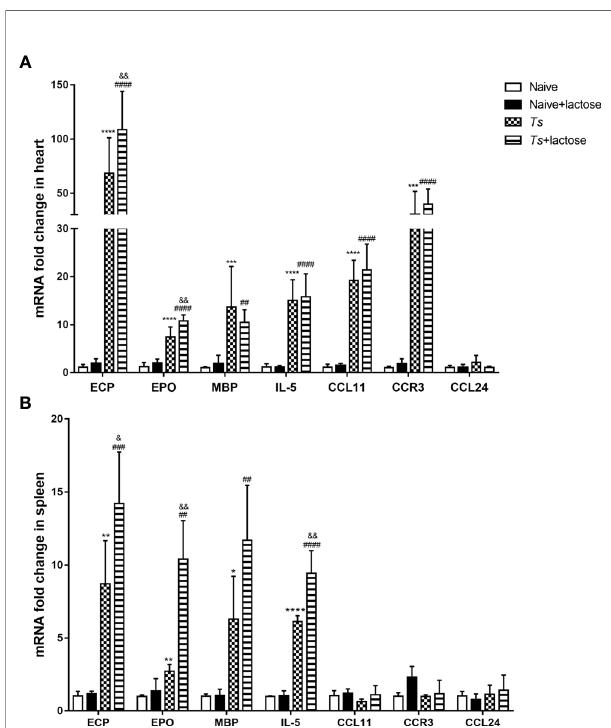
FIGURE 6 | The mRNA levels of ECP, EPO, MBP, IL-5, CCL11, CCR3, and CCL24 in the hearts (A) and spleens (B) of different groups of mice. Values are means from triplicate measurements and data are presented as means ± SD; there were eight mice in each group and the data shown are representative of those from two different experiments. * P < 0.05, ** P < 0.01, *** P < 0.001, and **** P < 0.0001 vs. uninfected mice. ## P < 0.01, ### P < 0.001, and #### P < 0.0001 vs . uninfected mice or uninfected mice with a -lactose treatment. & P < 0.05 and && P < 0.01 vs . T. spiralis- infected